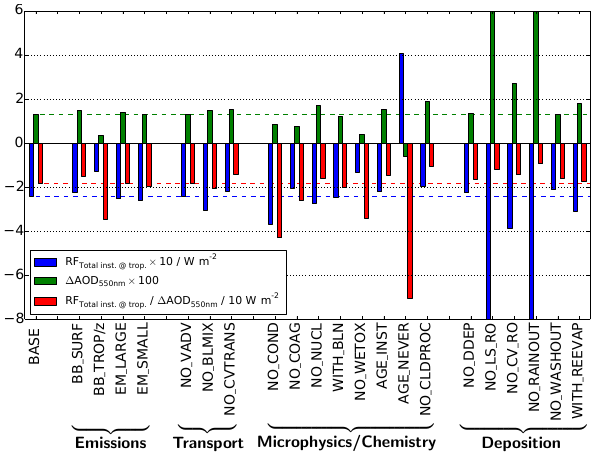
Figure 6. Annual- and global-mean direct radiative forcing (DRF), change in AOD, and AOD-normalised DRF, due to anthropogenic aerosol, for each of the HadGEM3–UKCA configurations. The dashed lines represent the values from the BASE simulation to aid comparison. Note that, to fit on the same scale, the AOD has been multiplied by 100 and the absolute and normalised DRF in Wm − 2 have been multiplied and divided by 10